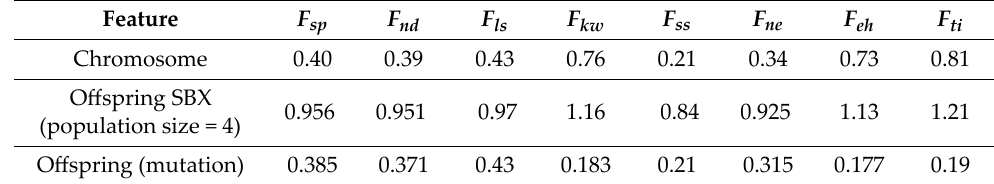
Table 6. Generated mutated offspring after polynomial mutation operation with feature